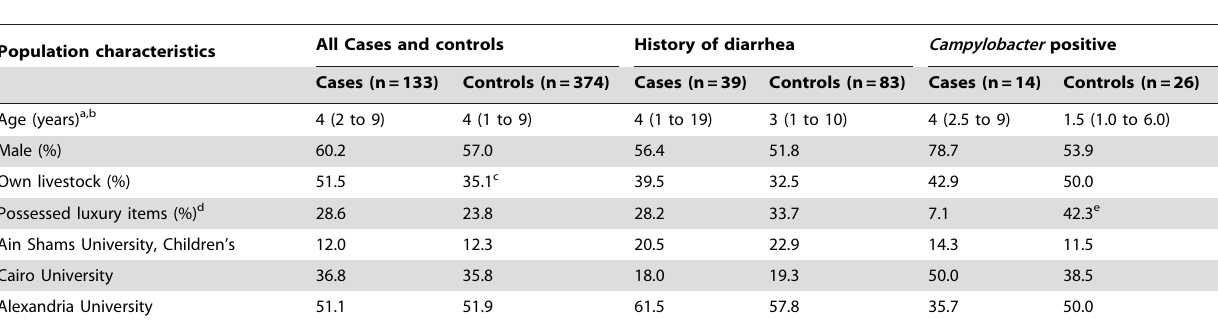
Table 1. Characteristics of cases and controls enrolled in study of Campylobacter infection and Guillain-Barre´ Syndrome, the Arab Republic of Egypt, April 2001 through September